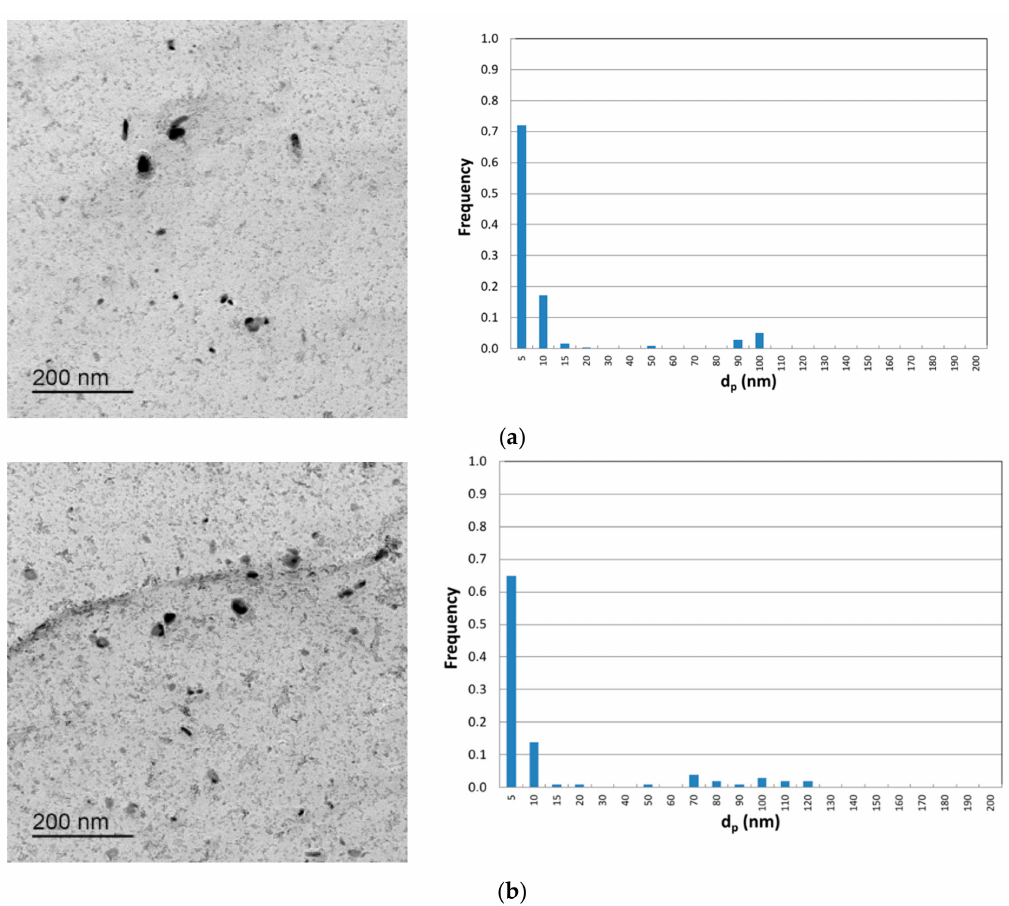
Figure 8. TEM images describing the precipitation state of ( a ) specimen PT- γ -3 and ( b ) specimen PT- γ -7.